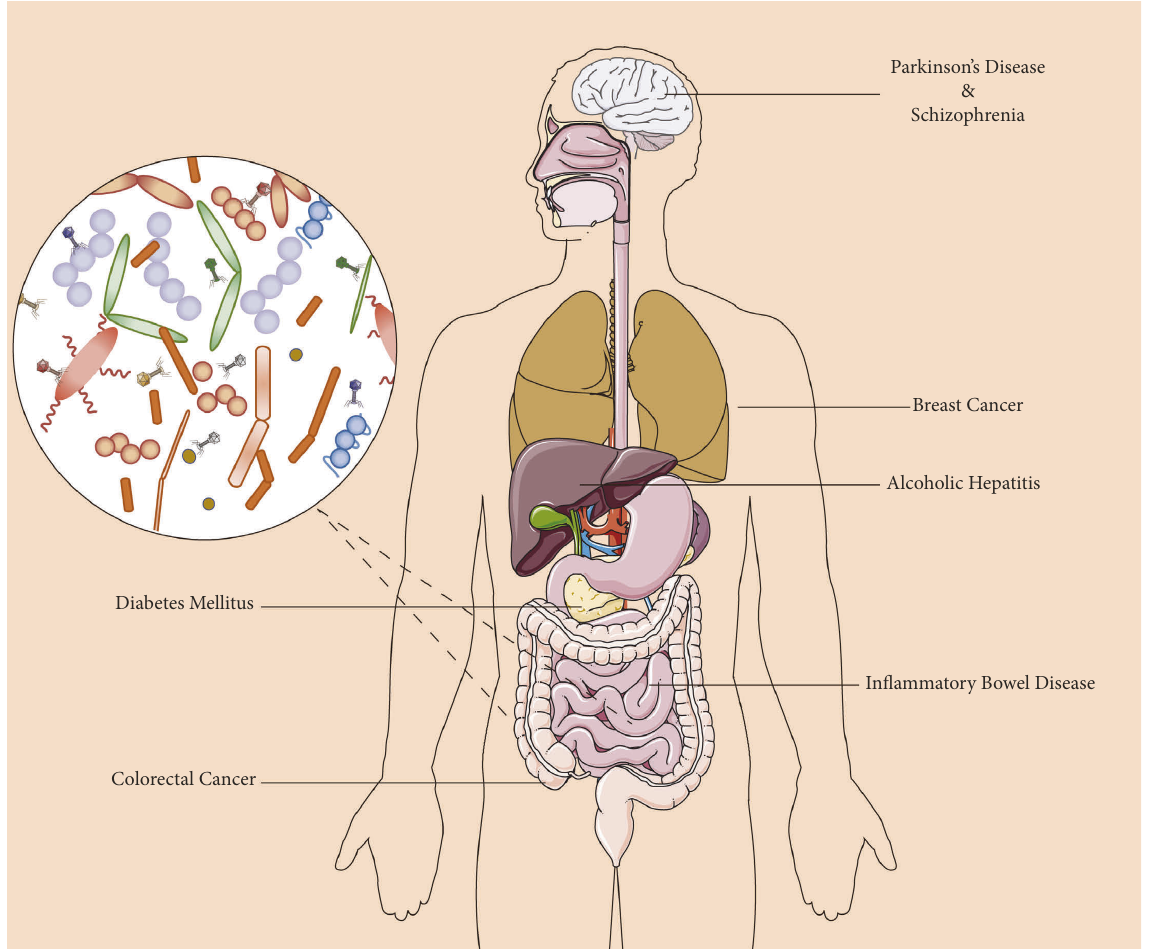
Figure 2: Phages for diagnosis and treatment of diseases beyond